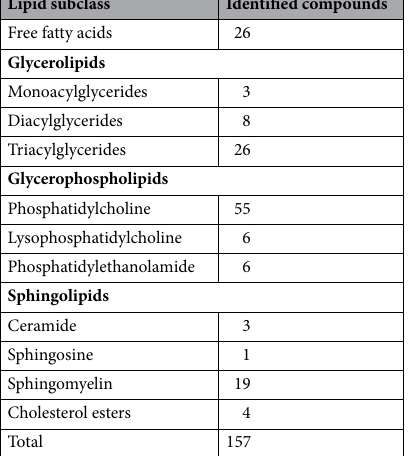
Table 2. Lipid species identified by ultra-performance liquid chromatography (UPLC) system coupled to an iFunnel quadrupole time of flight